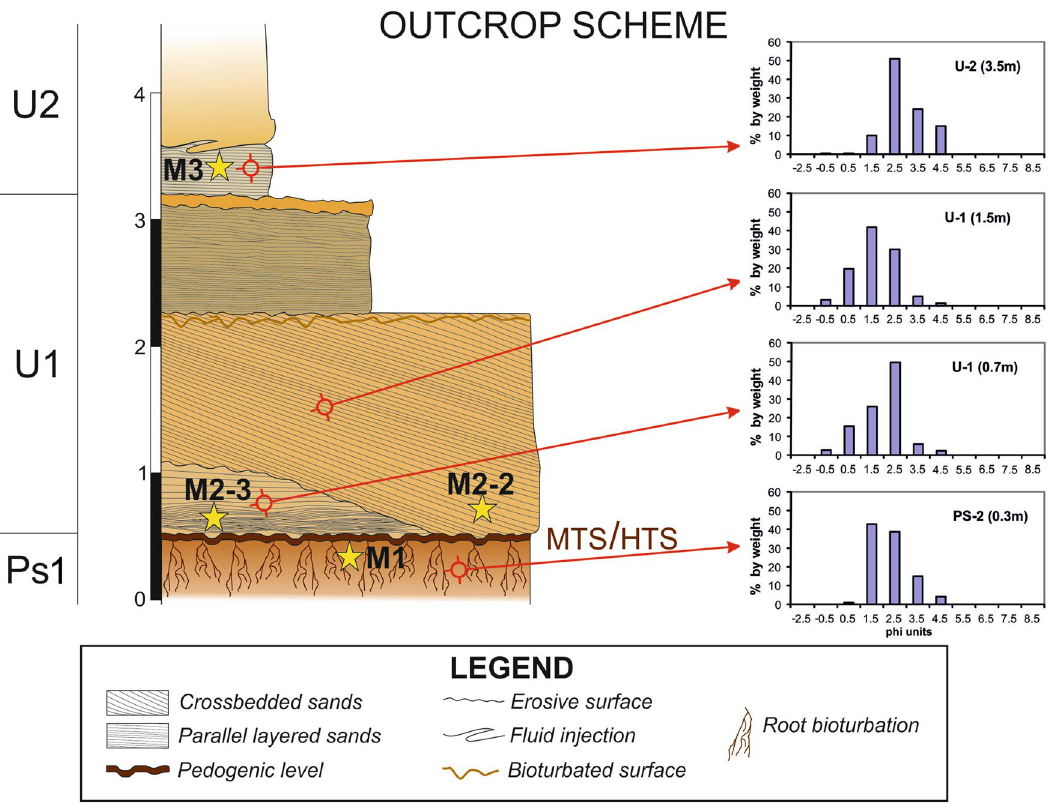
Figure 2. Sedimentary log of the footprints site in Matalascañas. The samples were obtained for dating (M1 to M3) and sediment grain-size histograms for the analysed samples. Units according to 16 . MTS: Matalascañas Trampled Surface 13 . HTS: Hominin Trampled Surface 6